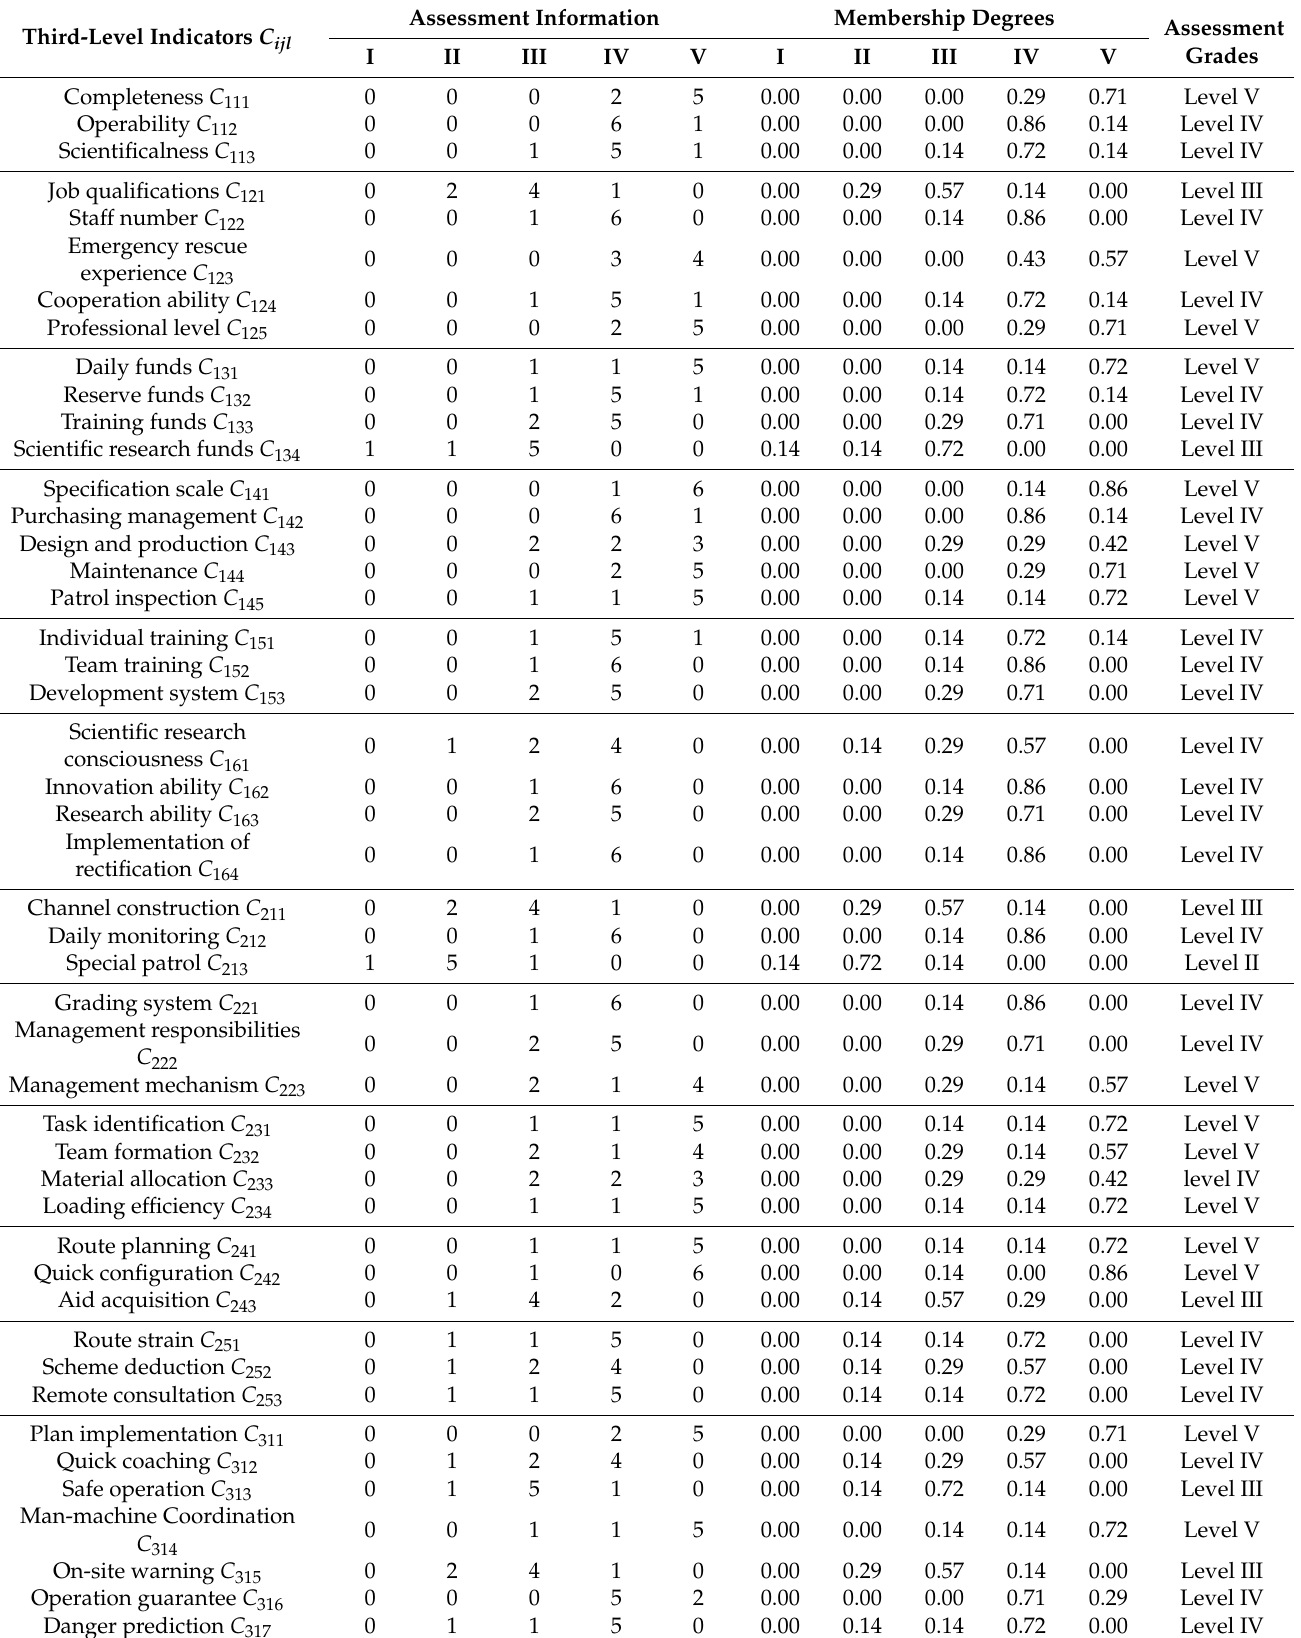
Table A12. Assessment information matrixes of third-level